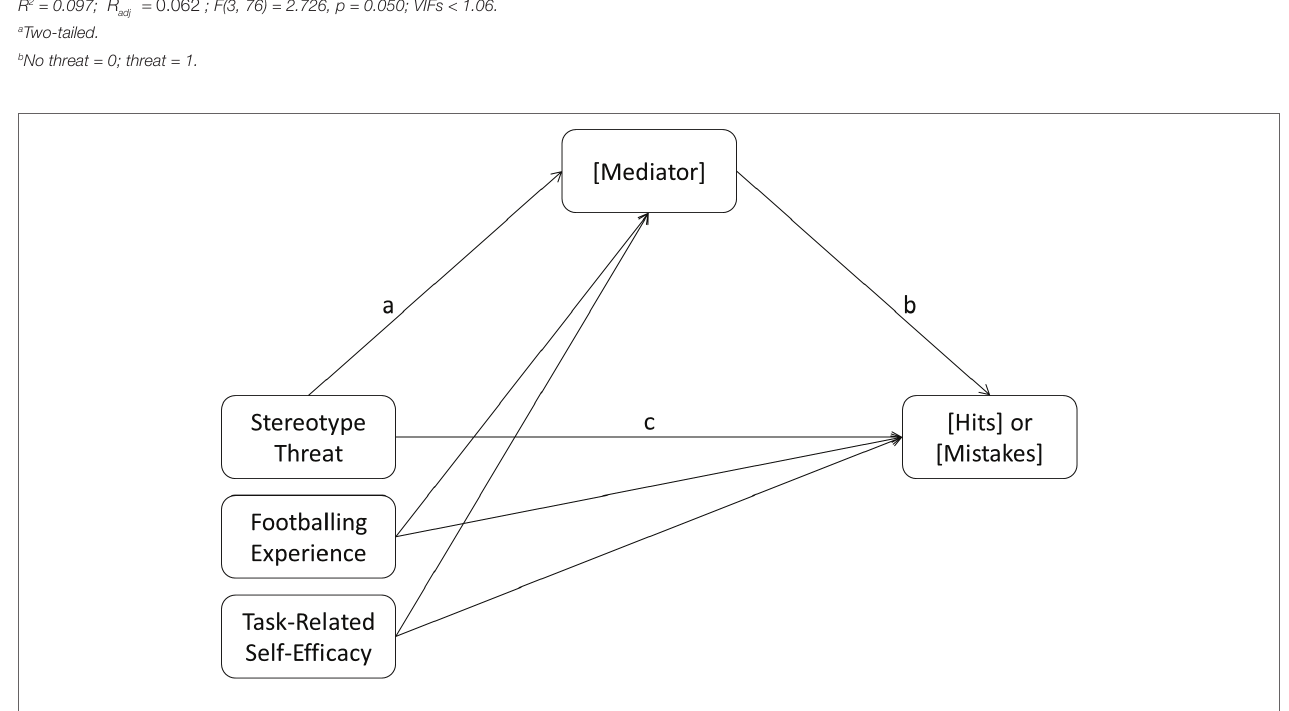
FIGURE 2 | Mediation